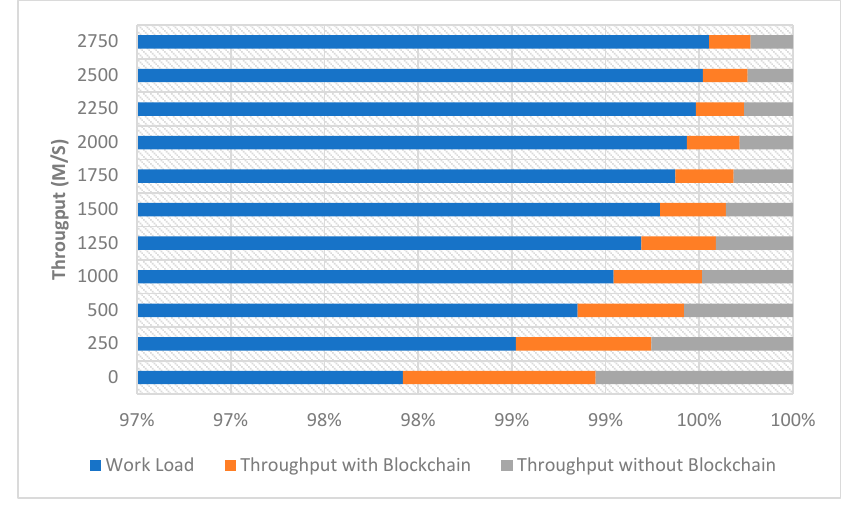
Figure 6. End-to-End Throughput.